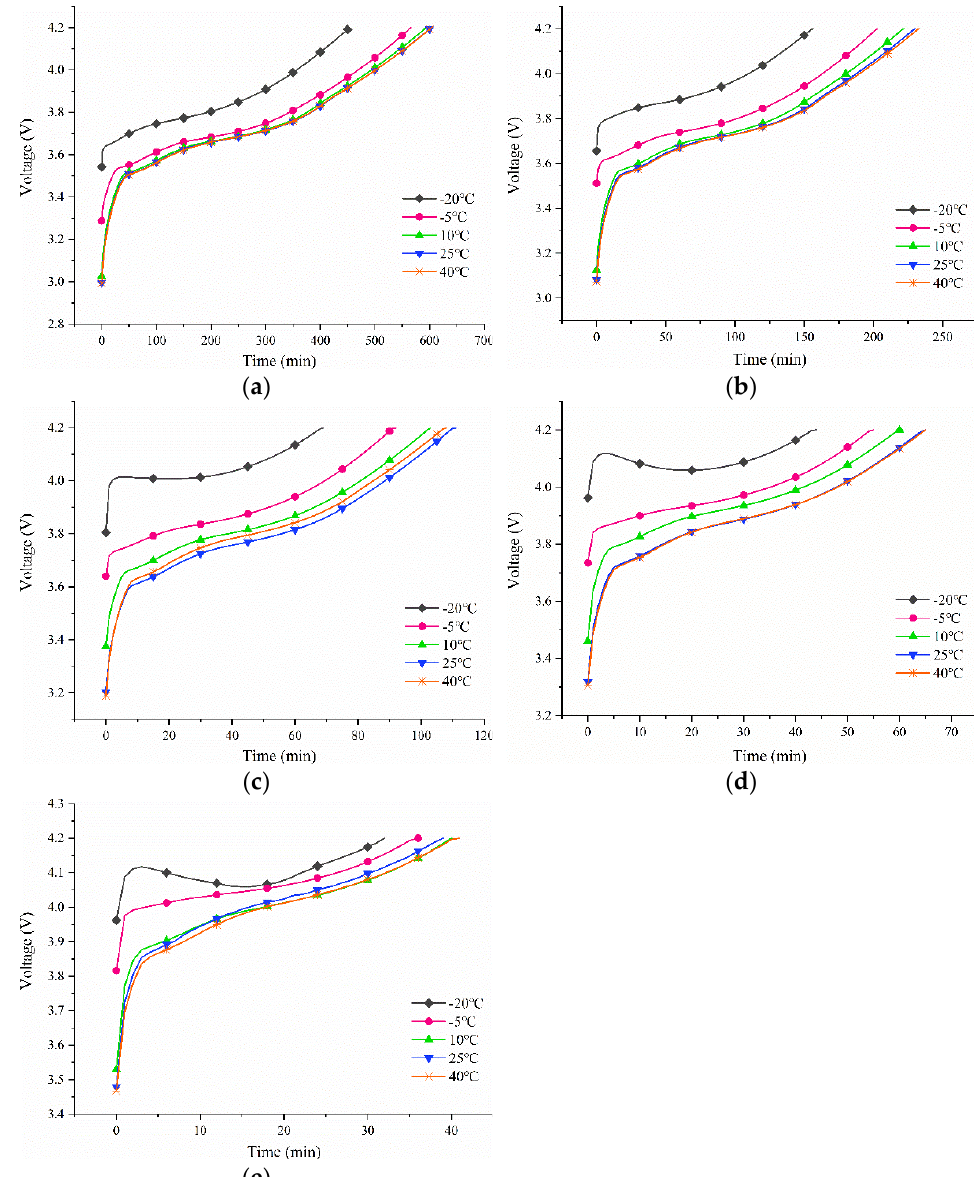
Figure 4. Charge voltage change curve: ( a ) 0.10C charge rate; ( b ) 0.25C charge rate; ( c ) 0.50C charge rate; ( d ) 0.75C charge rate; ( e ) 1.00C charge rate.